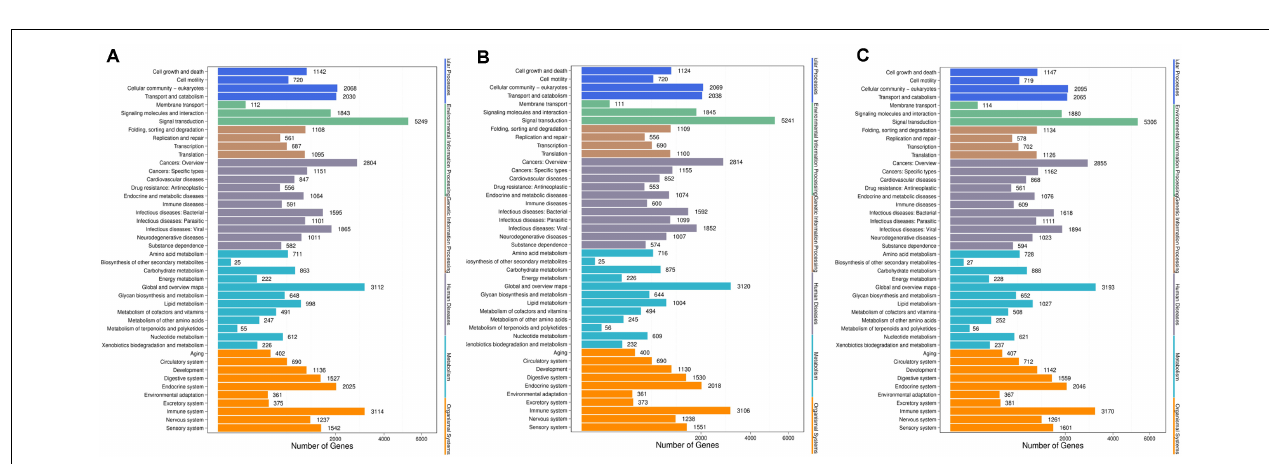
FIGURE 8 | Statistics of pathway enrichment in each pairwise. (A) Comparison between negative control group and positive control group. (B) Comparison between negative control group and P-ONE. (C) Comparison between negative control group and P-TWO. Rich Factor is the ratio of DESs target genes numbers annotated in this pathway term to all gene numbers annotated in this pathway term. Greater Rich Fator means greater intensiveness. Q -value is corrected P -value ranging from 0 to 1, and less Q -value means greater intensiveness. We just display the top 20 of enriched pathway terms.